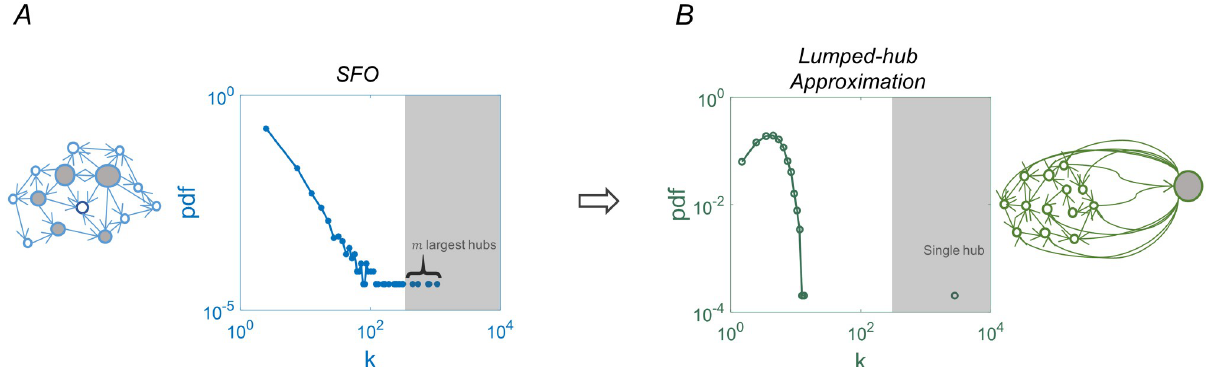
Fig 2. The lumped-hub approximation. (A) In a finite network with SFO degree distribution, the m largest hubs (gray shading) are connected to a macroscopic fraction of the network. The histogram shows the number of outgoing connections from each node. (B) In the lumped-hub approximation of the same network, these are substituted by one effective hub and the rest of the nodes are approximated by a Binomial network. The connection strengths of the single hub to the bulk are determined by summing the strengths of the m lumped hubs. The mean degree of the bulk, k the mapping. Here N =